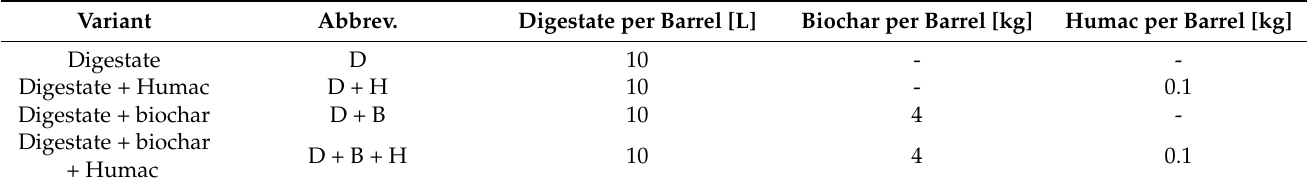
Table 1. Experimental variants of digestate.